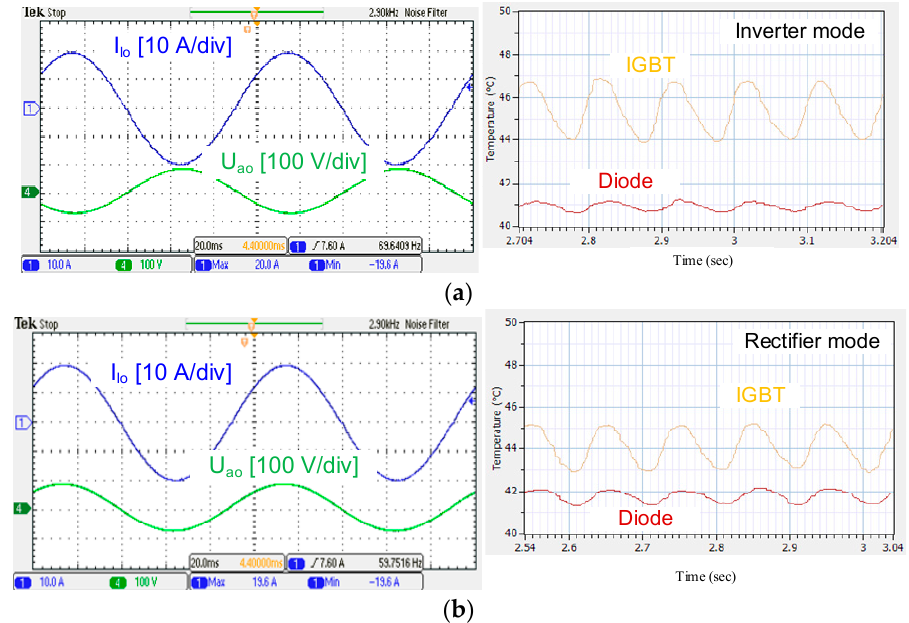
Figure 10. Experimental setup of H-bridge circuit. ( a ) Control block diagram. ( b ) Photo of experimental setup.